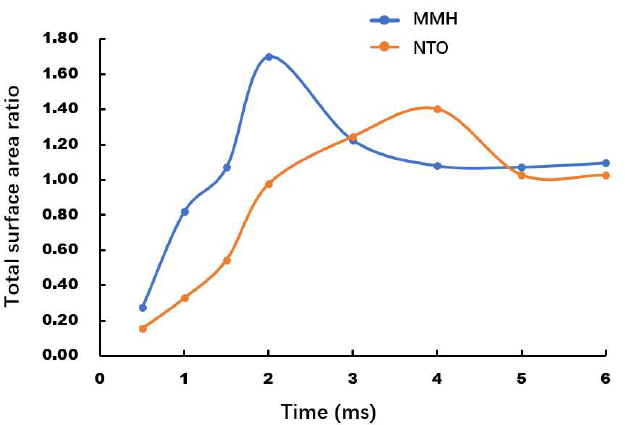
Figure 15. Comparison of MMH ( a ) and NTO ( b ) flowrate fluctuation under different switch speeds, with downstream orifice plate and 0.15 mm stroke.